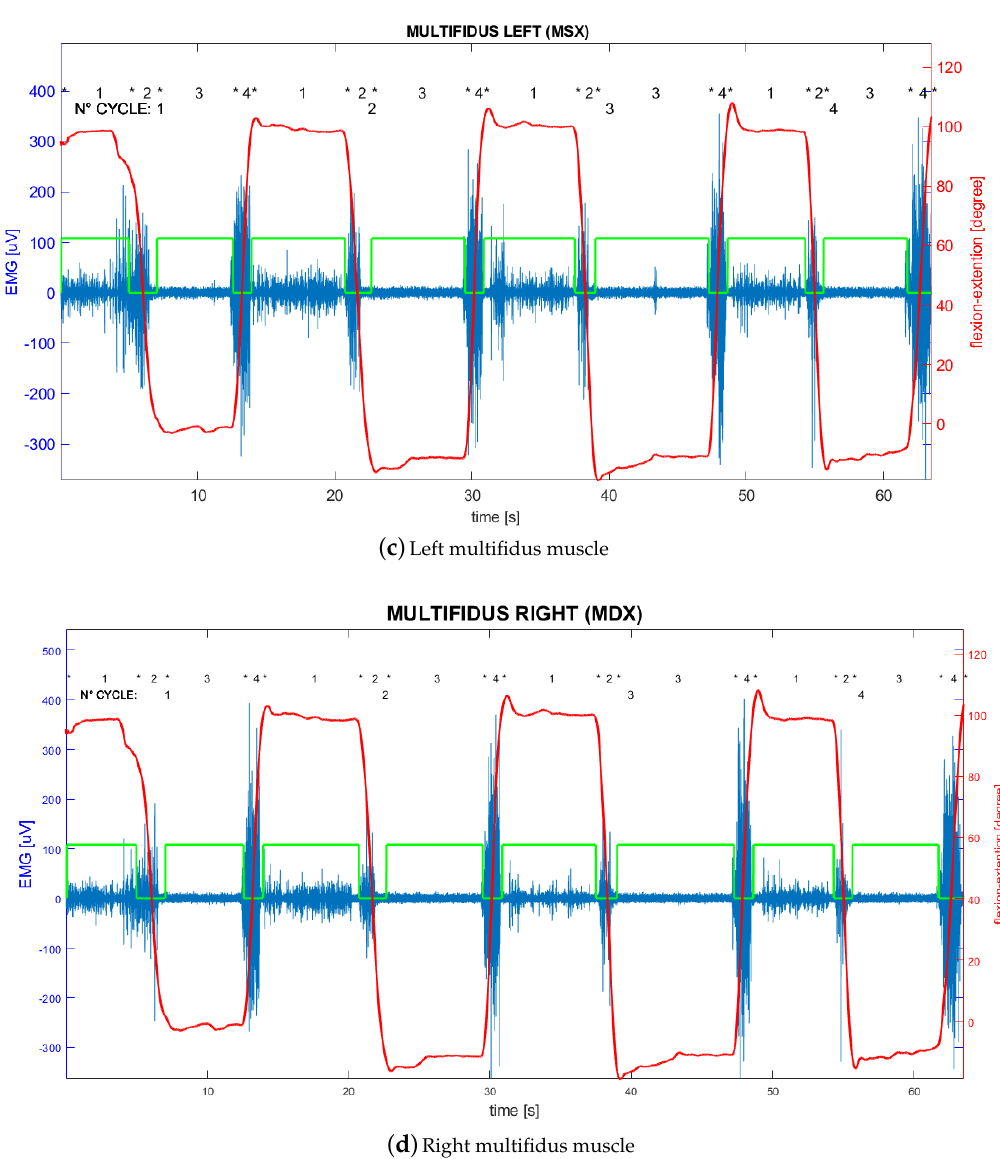
Figure 5. Graphic representation with the signals superimposition (filtered sEMG signal in blue, inclination signal in red, phases signal in green), phases (upper numbers) and cycles (lower numbers). It is referred to a healthy